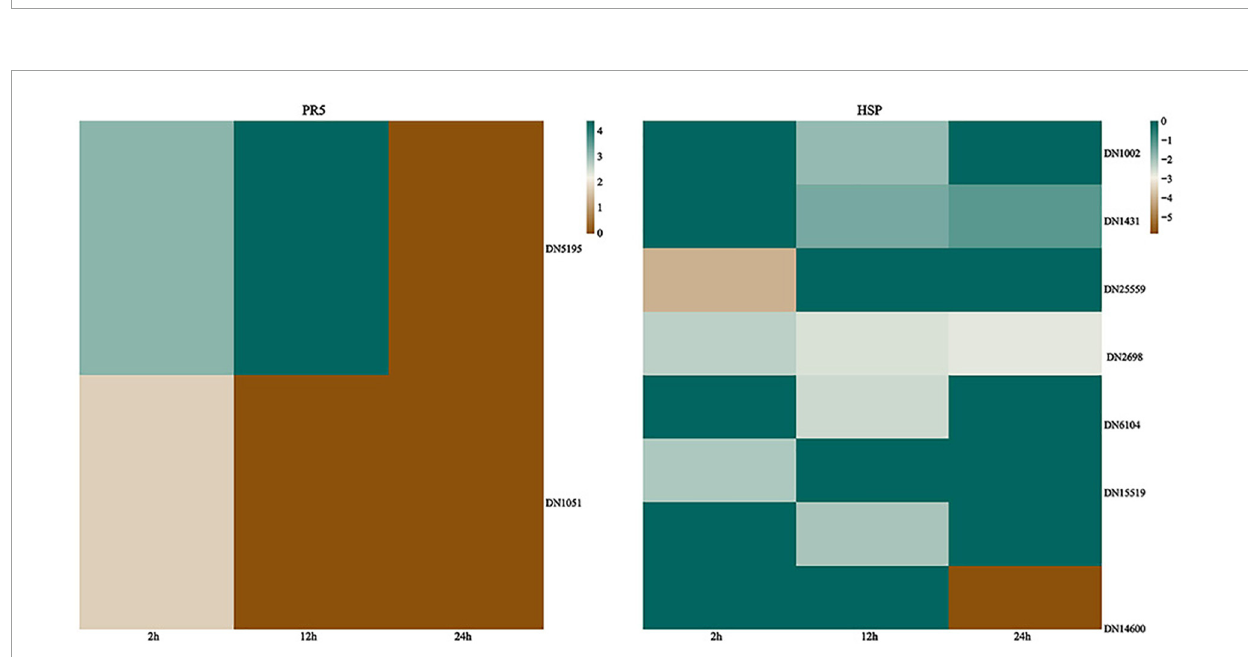
FIGURE7 Left : Heatmaps of differentially expressed genes (DEGs) encoding thaumatin-like proteins (TLPs); right : Heatmap of DEGs encoding heat shock proteins (HSPs). The log 2Foldchange was colored using Genescloud tools (green for up-regulated, brown for down-regulated), each horizontal row represents a DEG with its gene